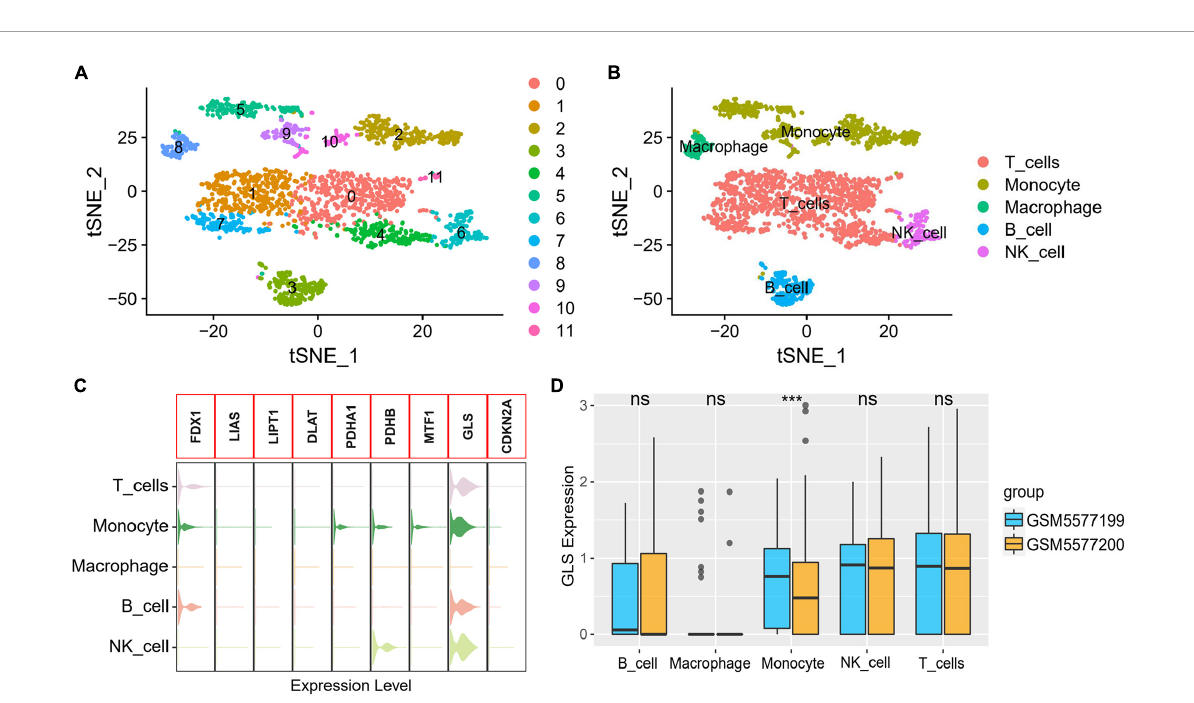
FIGURE9 GLS expression in single-cell data. (A) Single-cell sequencing data dimensionality reduction, clustering results. (B) t-Distributed stochastic neighbor embedding (tSNE) visualization of cell annotation results. (C) Expression of CRGs in different cells. (D) Differential expression of GLS in five myeloid cells between two groups. *** P <